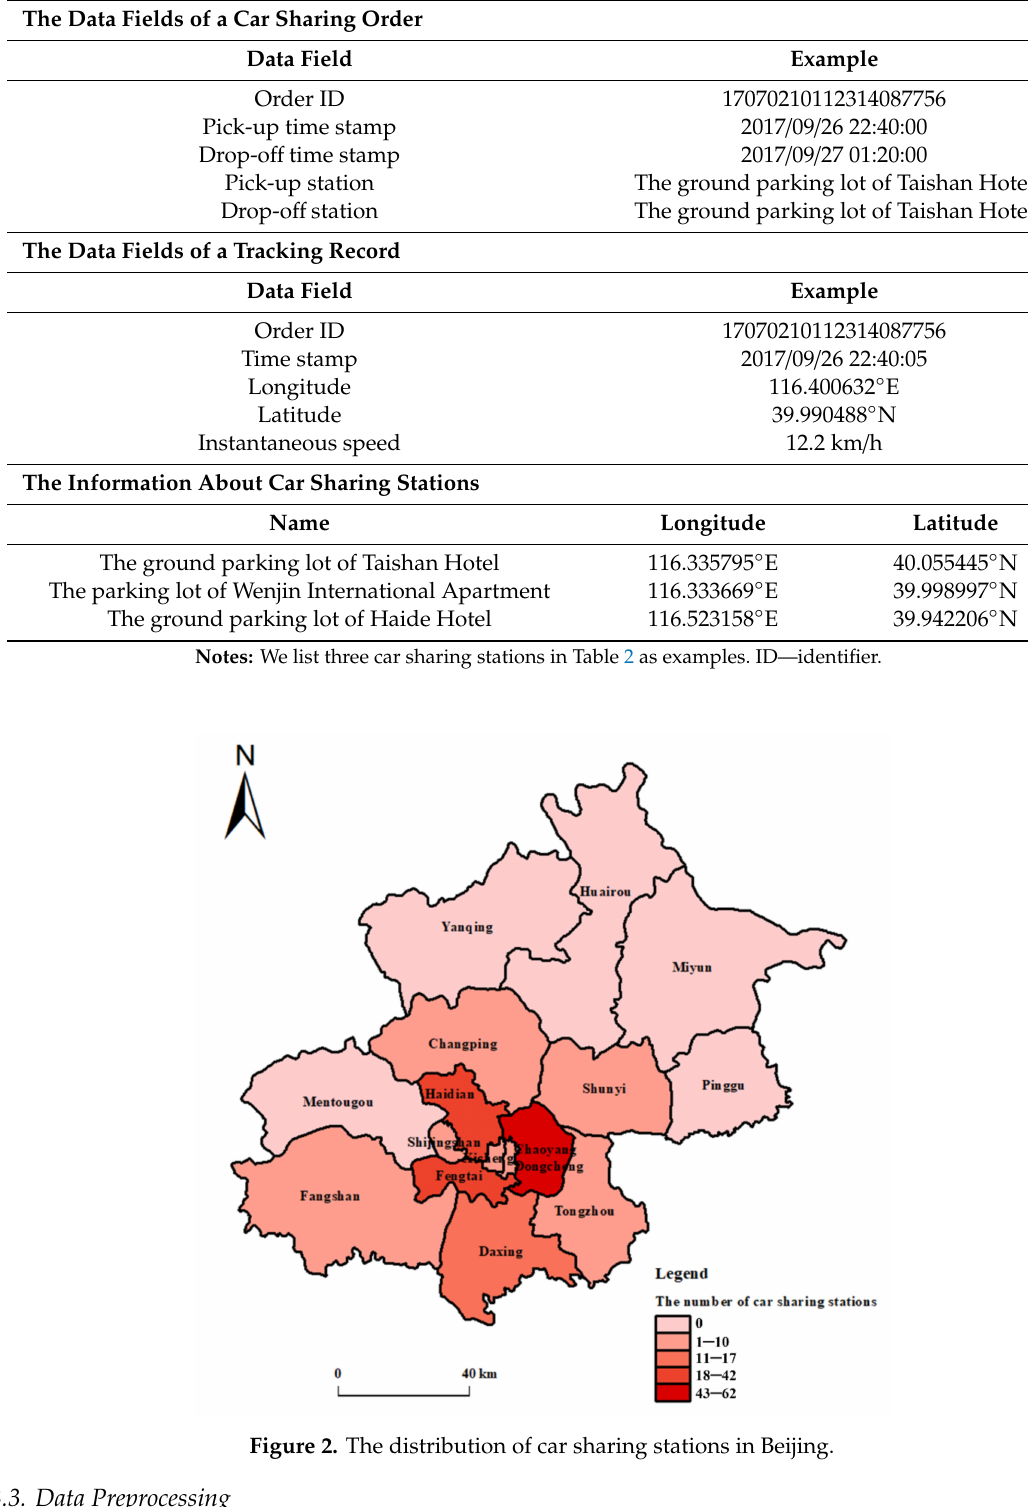
Table 2. The research data.